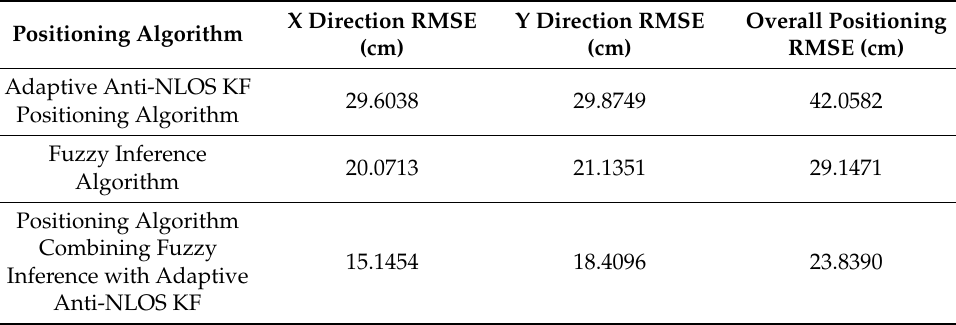
Figure 11. RMSE curves of the positioning trajectories. Table 3. Mobile positioning of RMSEs in NLOS